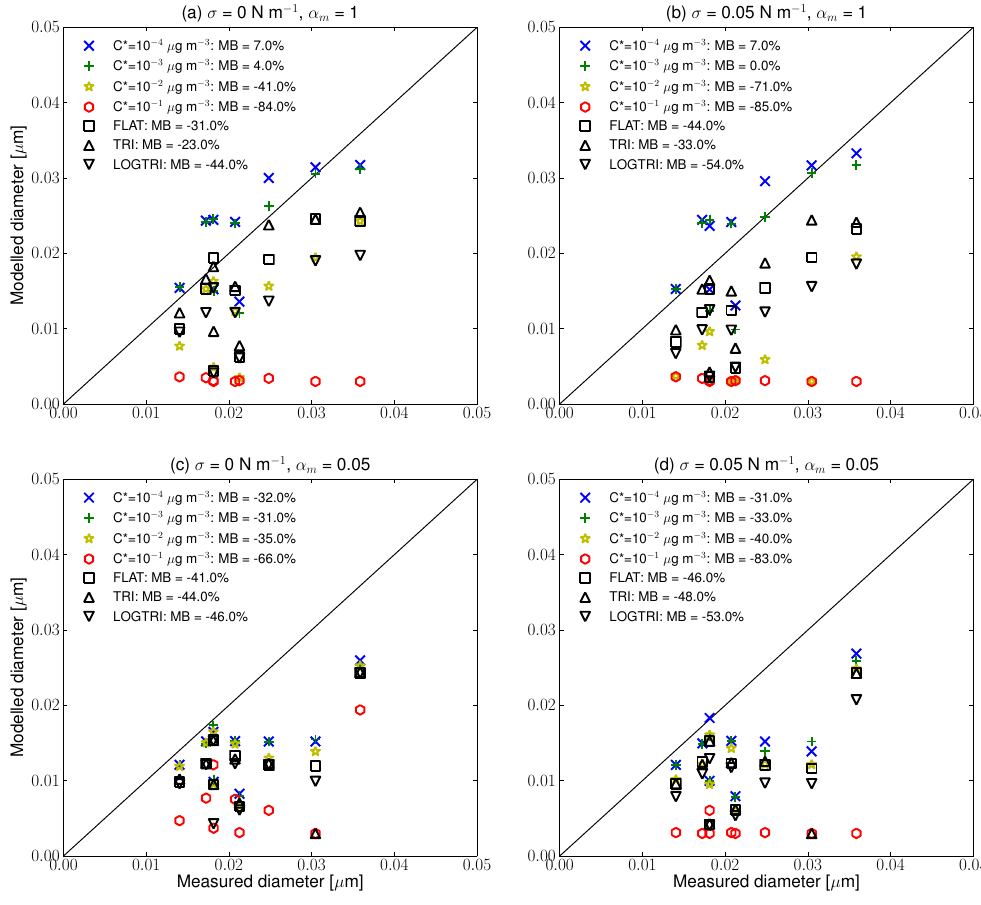
Fig. 4. Comparison of the simulated diameter to measured diameter of the nucleation mode after SOA condensation has stopped for the 7 events at Hyyti¨al¨a and Egbert. All simulations assumed that pre-existing organics have C ∗ = 10 − 5 µgm − 3 and assumed that organics do not partition into sulfate and water. In each panel, different cases regarding the volatility distribution of organics are marked by different colors and symbol shapes. Panel (a) assumed surface tension is 0Nm − 1 and accommodation coefficient is 1. Panel (b) assumed surface tension is 0.05Nm − 1 and accommodation coefficient is 1. Panel (c) assumed surface tension is 0Nm − 1 and accommodation coefficient is 0.05. Panel (d) assumed surface tension is 0.05Nm − 1 and accommodation coefficient is 0.05. MB denotes the mean bias across the 9